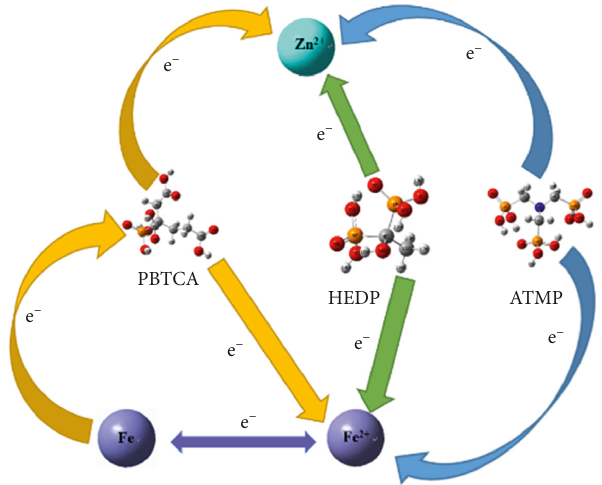
Figure 6: Electron-flow diagram of the corrosion inhibition mechanism between the inhibitor and carbon